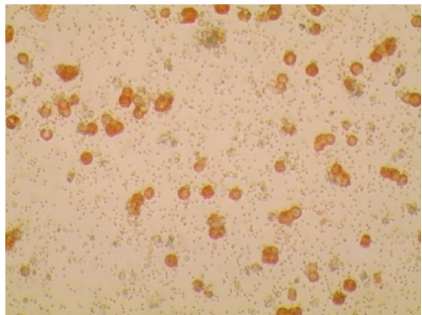
Figure 1. Hemadsorption (HAD) assay for the detection of African swine fever virus (ASFV) in a field sample of spleen tissue. The 10 times dilution of the supernatant of the homogenate was inoculated into porcine alveolar macrophage (PAMs) with 1% pig blood cells. HAD was observed within 24 h. Original magnification 100 ×